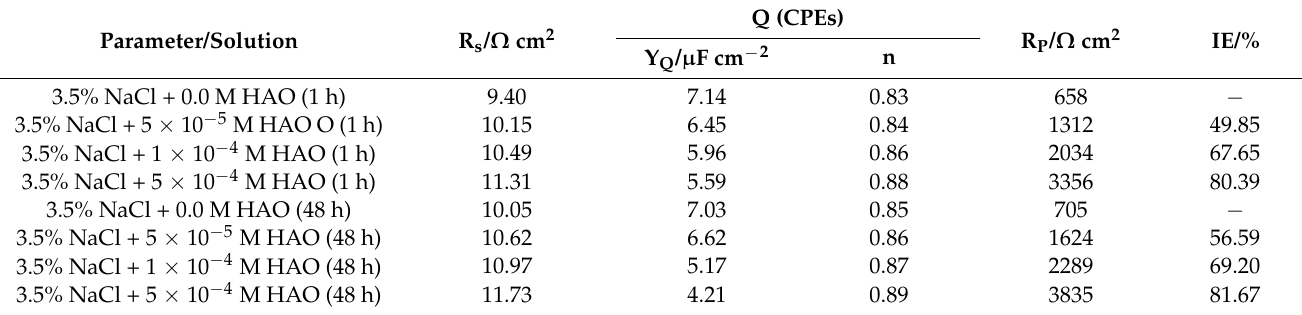
Table 3. EIS parameters obtained by fitting the impedance data for iron in chloride solutions with and without HAO